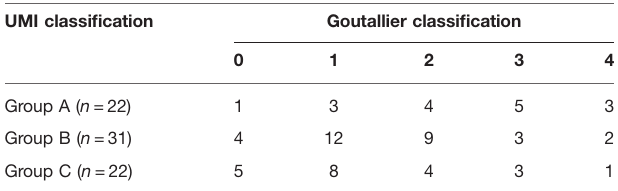
TABLE 1 | Baseline statistics of patients. TABLE 2 | Comparison of the fatty degeneration of rotator cuff among different